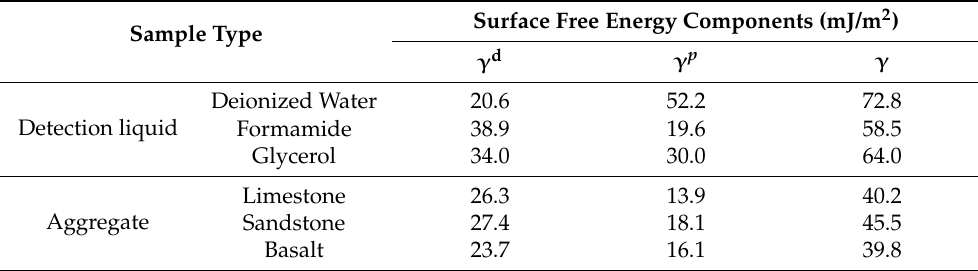
Table 5. Test results of surface free energy of aggregate and measured